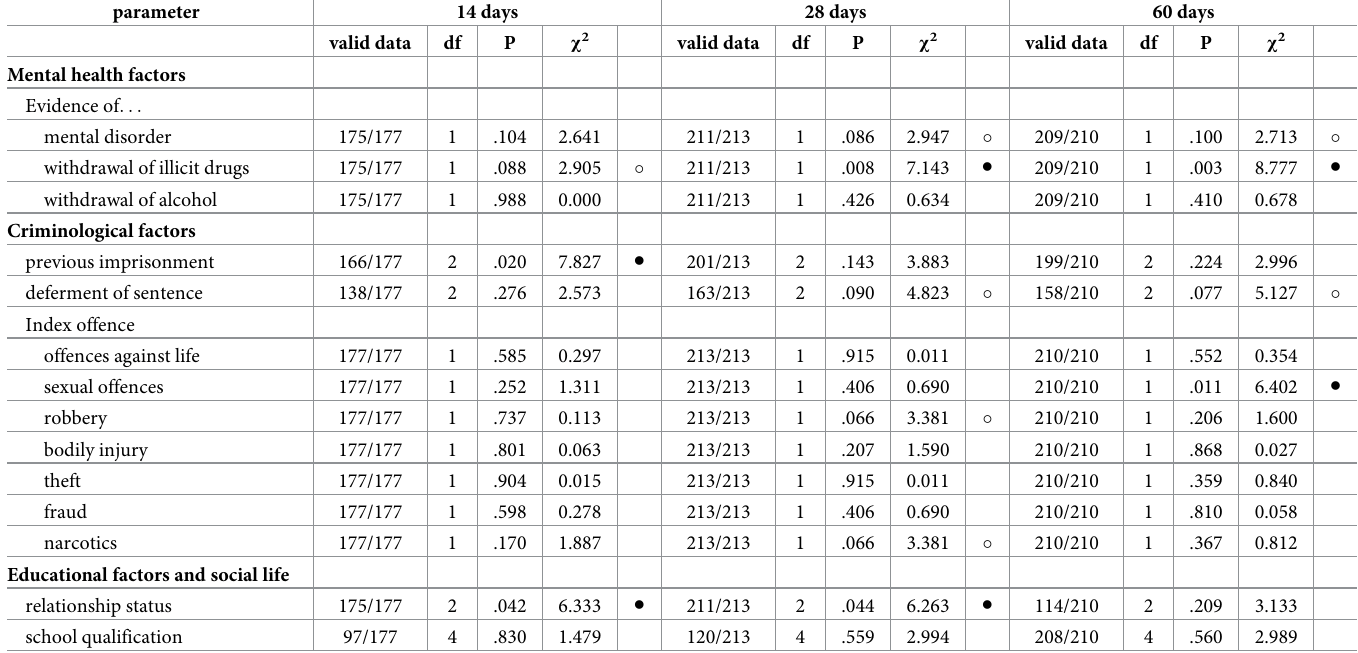
Table 2. Associations between mental health, criminological, and social factors on timing of prison suicides.